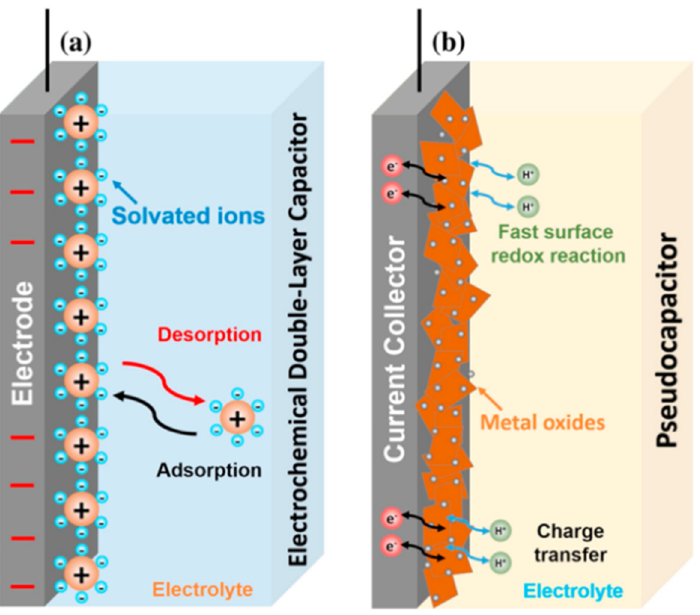
Figure 1. Comparison of charging in ( a ) EDLC (carbon) and ( b ) pseudocapacitor (metal oxides) [37]. Reproduced with permission from ref. [37].